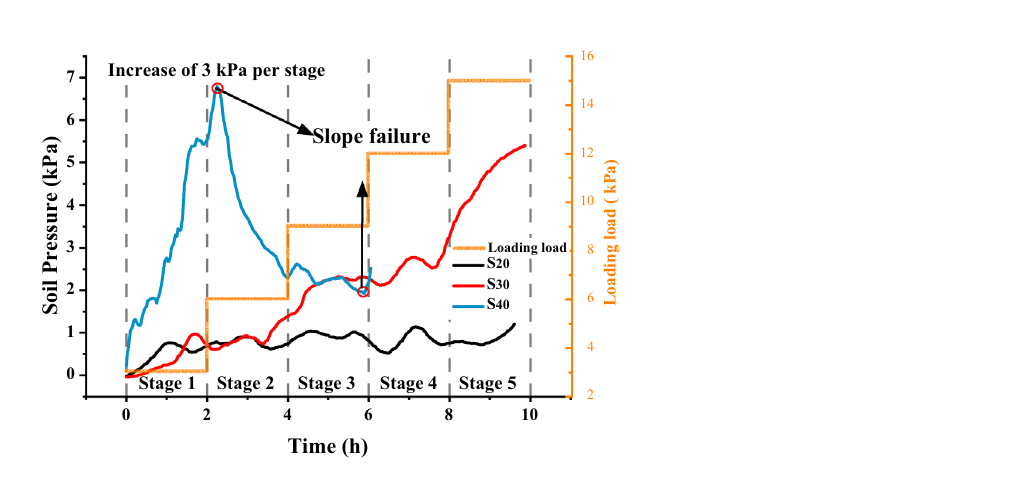
Figure 7. Soil pressure after five freeze–thaw